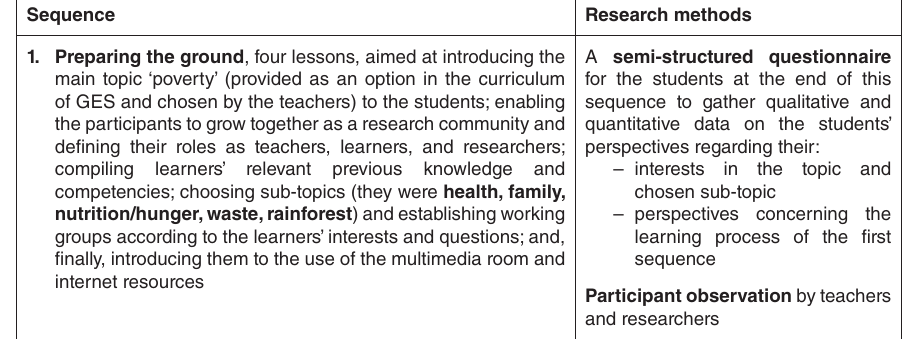
Table 1: Sequences and research methods of the case study